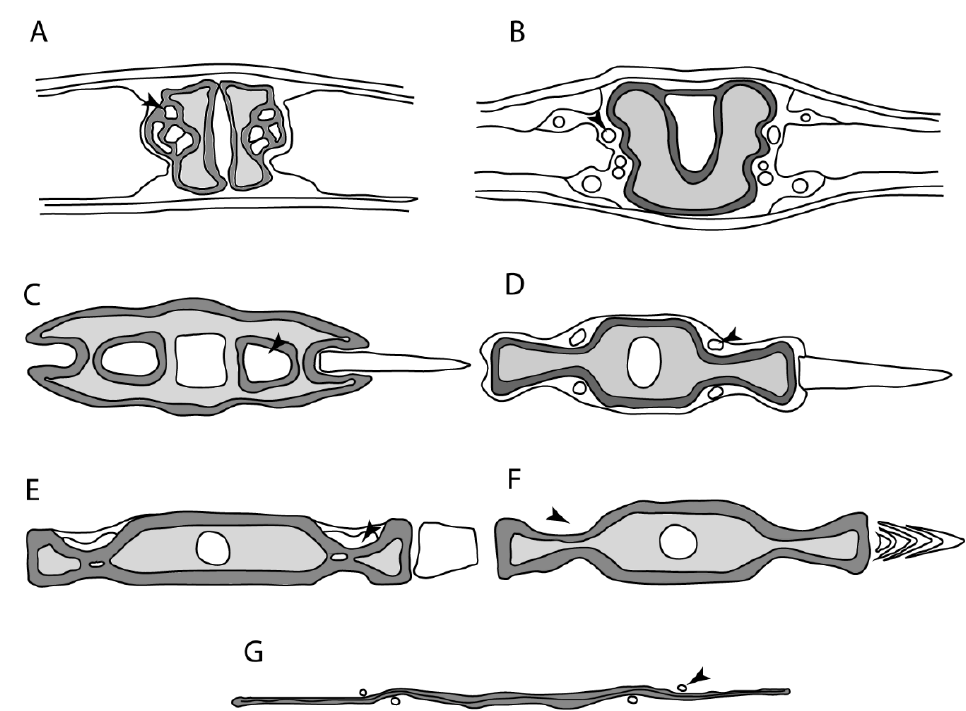
Figure 10. Interpretative line drawings of the lateral face of the neurocranium and sections of the rostral cartilages with the passage of superficial ophthalmic nerve in different chondrichthyan groups: State (0): ( A ) of Rhinobatos typus ; ( B ) Aptychotrema rostrata based on Wueringer et al. Text-Figure 4 in [76]; ( C ) Pristis sp. (BRC–Pristis). State (1): ( D ) Pristiophorus nudipinnis based on Wueringer et al. Text-Figure 4 in [76]; ( E ) Onchopristis numidus based on Cappetta Text-Figure 4 in [77] and Wueringer et al. Text-Figure 4, NHMUK PV P 75503 in [76]; ( F ) † Schizorhiza stromeri aster Smith et al. Figures 1a–l and 2a–f; NHMUK PV P 73625 in [80]; ( G ) Libanopristis hiram based on Cappetta Text-Figure 3 in [77]. Arrowheads indicate the passage of the superficial ophthalmic nerve through the ethmoidal